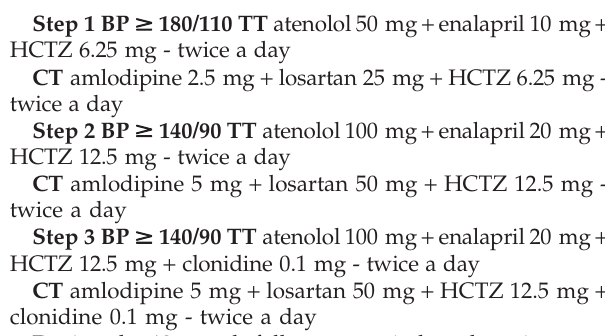
N Drug treatment regimens for the HT3